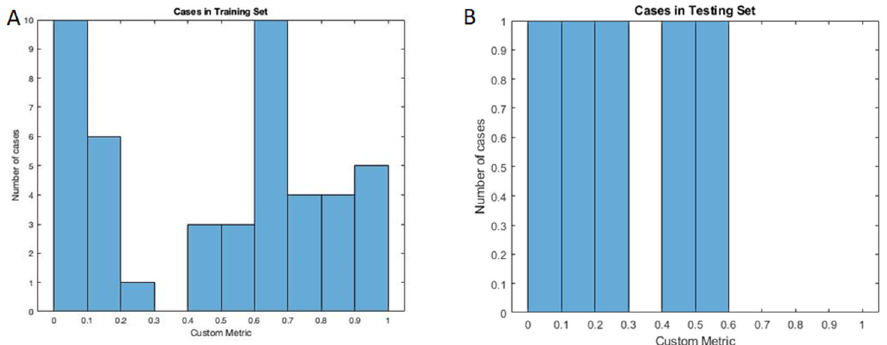
Figure 3. The histogram of the custom metrics between the manual segmentation and the U-Net generated segmentation for cases with unobturated MB2. ( A ) training set results; ( B ) testing set results. Table 2. Rating of the segmentation performance of the U-Net